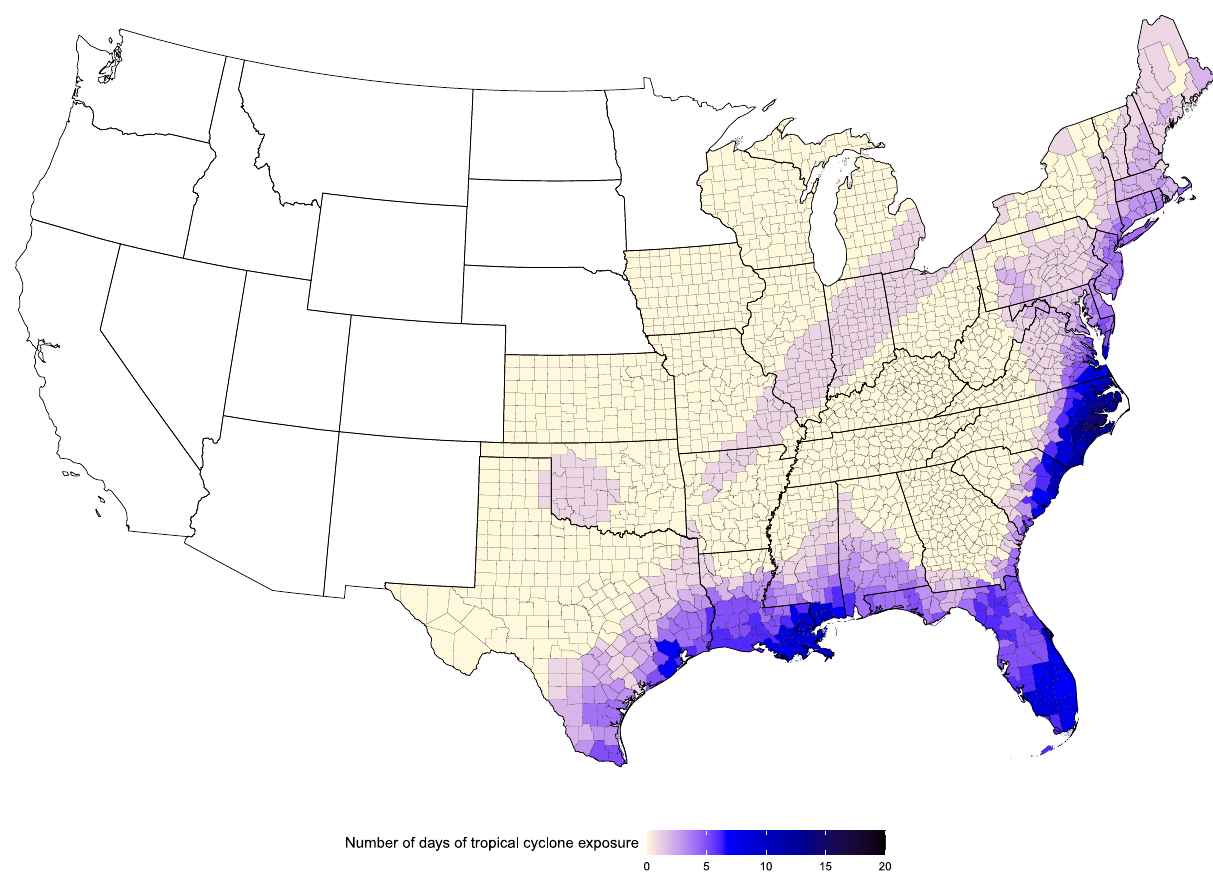
Fig. 1 Tropical cyclone exposure days. Number of days with tropical cyclone exposure by county for 1999 –